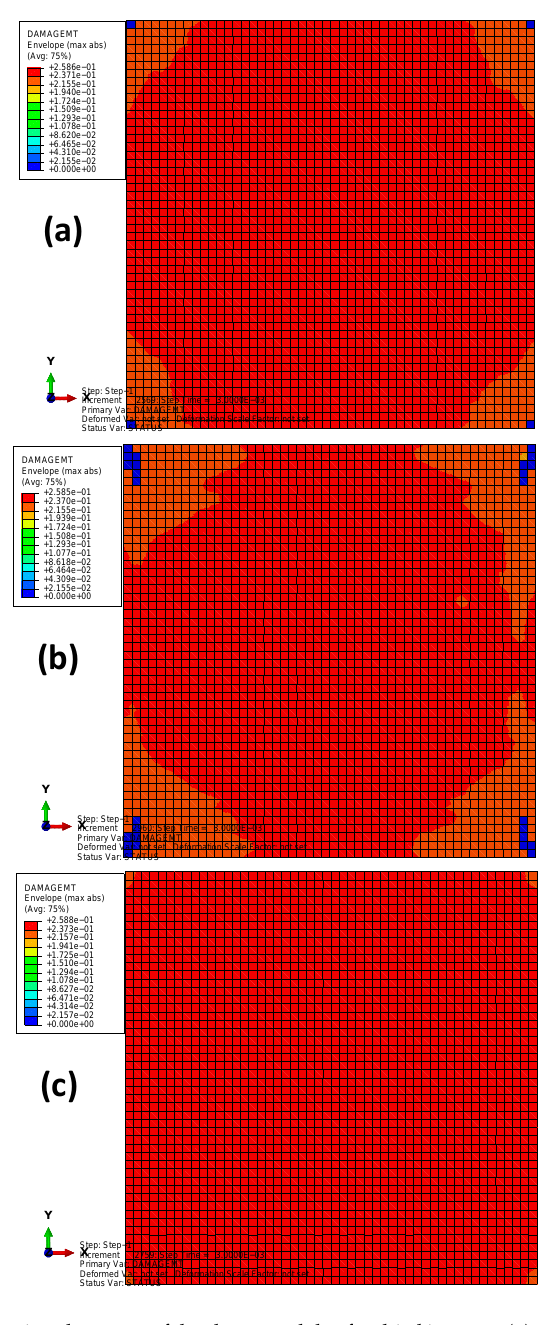
Figure13. Thematrixtensiondamagesofthethreemodelsafterbirdimpact: ( a )material1; ( b )material2; Figure 13. The matrix tension damages of the three models after bird impact: ( a ) material 1; ( b ) ( c ) material material 2; ( c ) material 3.